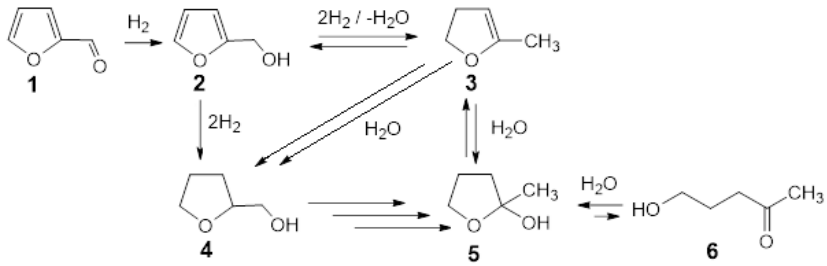
Figure 11. Scheme of the reaction based on the main products of the furfural reduction in the aqueous phase over 5% Pd-1% Au/SiO 2 catalyst.